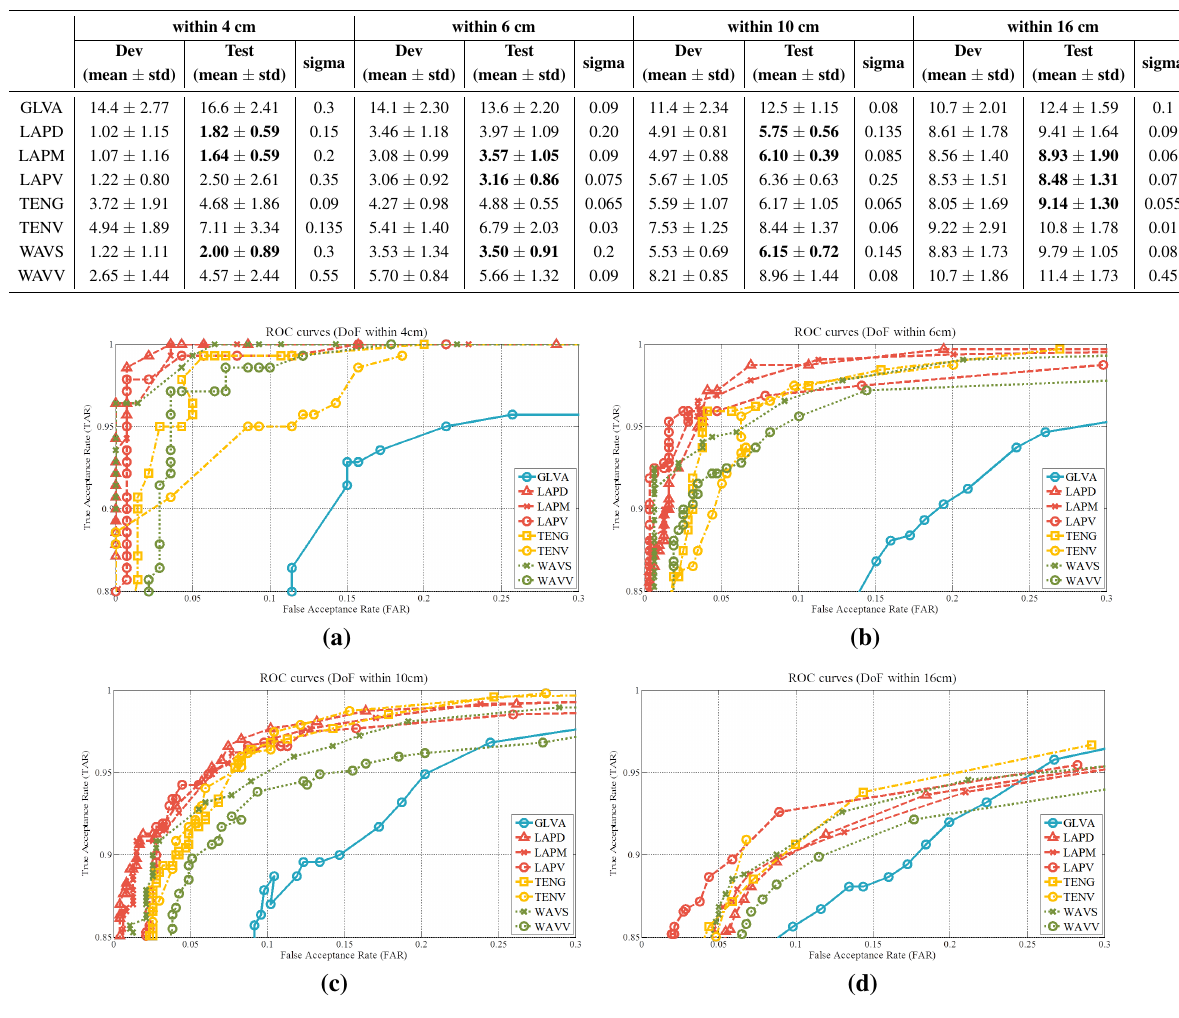
Table A2. HTERs (%) of the focus features.